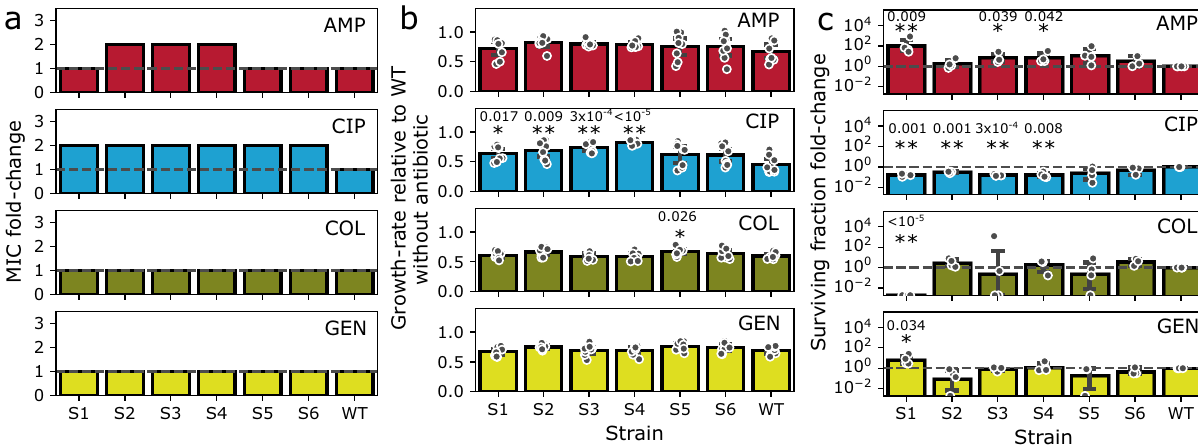
Fig. 5 Evolution of BAC-tolerance affects susceptibility to antibiotics. Resistance ( a ), fi tness with sub-inhibitory levels of antibiotics ( b ), and tolerance ( c ) against antibiotics from the classes of β -lactams (ampicillin; AMP), fl uoroquinolones (cipro fl oxacin; CIP), antimicrobial peptides (colistin; COL), and aminoglycosides (gentamicin; GEN) were assessed. a Evolved clones show increased MICs against AMP and CIP. Bars represent the maximal value of three biological replicates. b Growth-rate of the clones at sub-inhibitory levels of antibiotics. Bars represent the mean ± 95% C.I., n = 8 biological replicates. Signi fi cant differences to the wild-type are indicated by asterisks: (cid:1) p < 0.05; (cid:1)(cid:1) p < 0.01 (two-tailed unpaired t-test of growth rate). c Evolution of tolerance against BAC can increase survival, but also lethality upon antibiotic stress. Bars represent geometric mean ± 95% C.I., n = 4 biological replicates. Signi fi cant differences to the wild-type are indicated by asterisks: (cid:1) p < 0.05; (cid:1)(cid:1) p < 0.01 (two-tailed one-sample t-test of log-transformed survival fraction fold-change for difference to 0). Half circles on the x -axis indicate replicates with a surviving fraction below the detection limit. These data points were excluded from statistical testing, except for S1 COL. Source data are provided as a Source Data fi le. Exact p -values are indicated above the